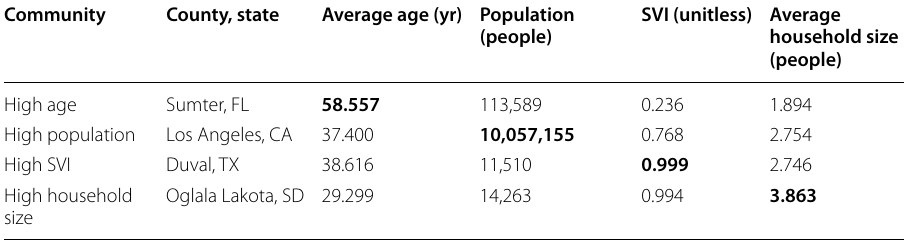
Table 1 Communities based on U.S. counties having high SVI, high average age, high average household size, or high population (criteria for selection shown in bold) Community